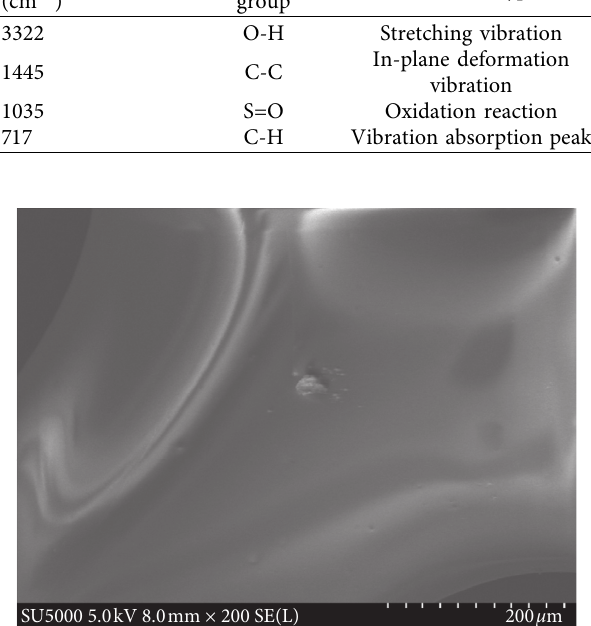
Figure 2: MA by electron